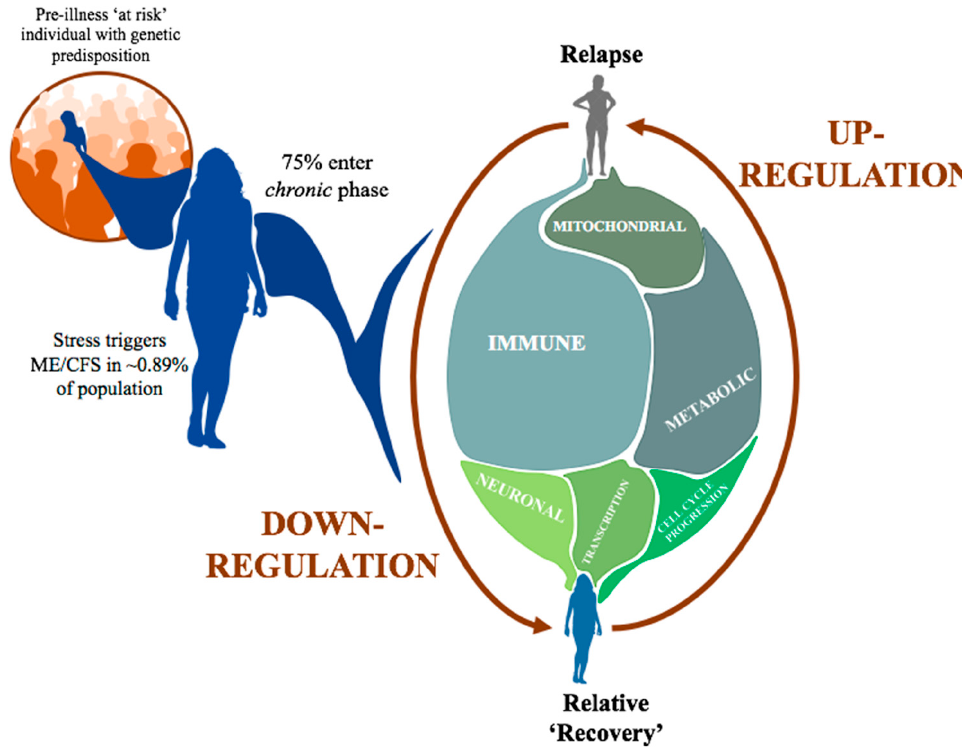
Figure 6. Summary of the longitudinal timeline of a ME/CFS patient. The initial external trigger for ME/CFS is a ‘stress event’ (for example, a viral infection- upper left in Figure 6) in a genetically susceptible person. Following progression into the chronic state patients experience frequent relapse events, which as this investigation suggests are primarily associated with the up regulation of a number of key biological systems.